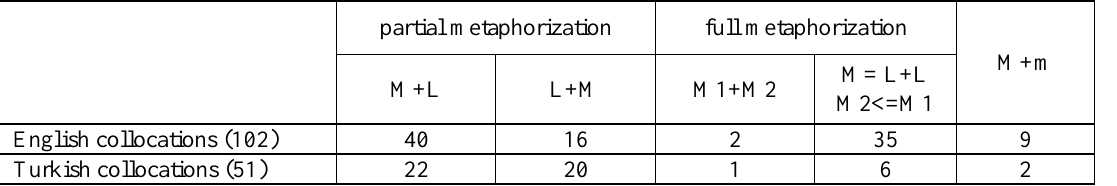
Table 2 – The main structural semantic patterns of attributive-substantive metaphorical